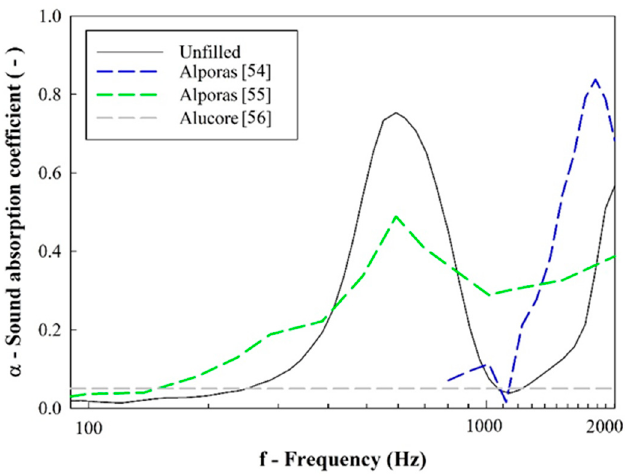
Figure 19. Sound absorption coefficient comparison: designed cellular solids vs. other Al foams.